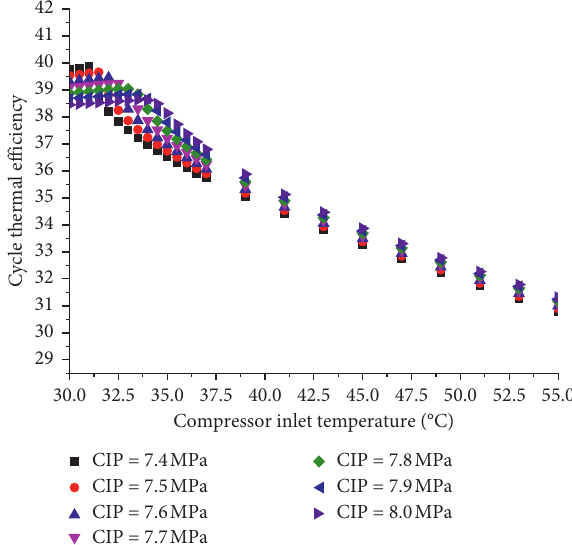
Figure 12: Effects of recuperator UA on the cycle thermal efficiency for